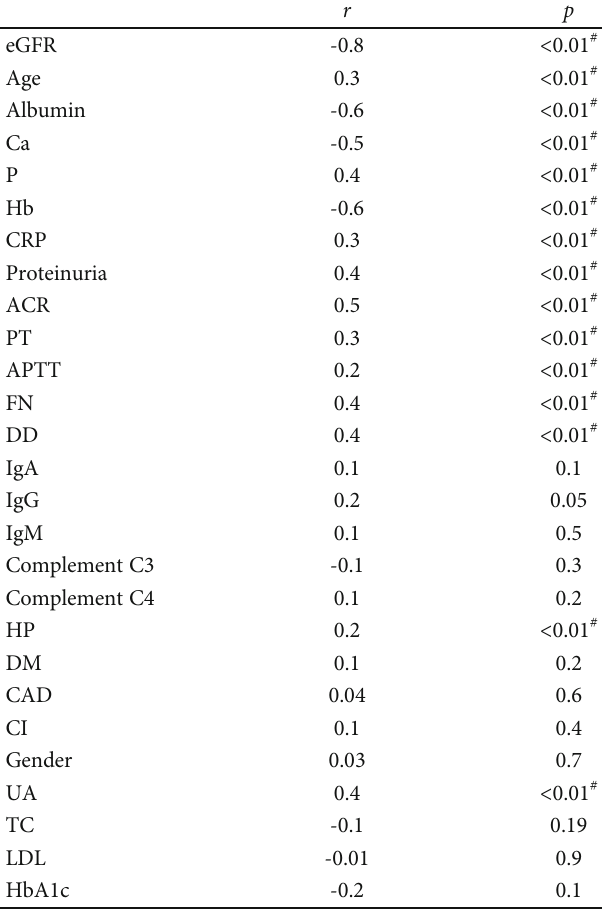
Table 2: Correlations of IDO and CKD-related